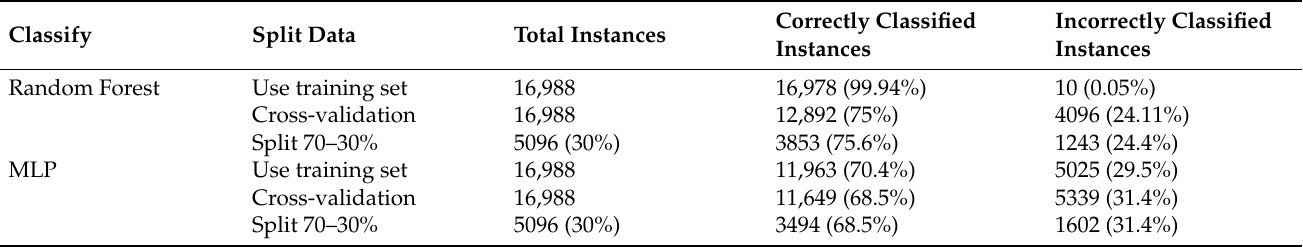
Table 4. WEKA results of